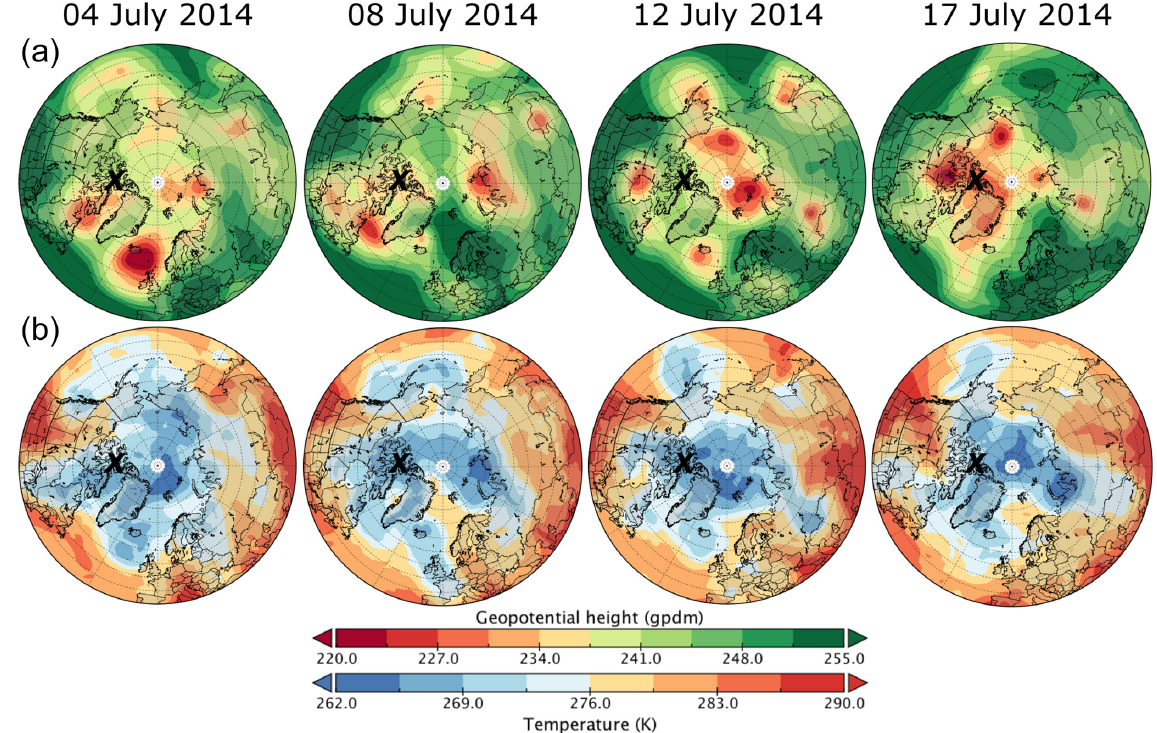
Figure 3. Weather charts for the NETCARE summer campaign in July 2014 showing the 750hPa geopotential height (a) and tempera- ture (b) evolution over the duration of the campaign. Resolute Bay is marked with a black